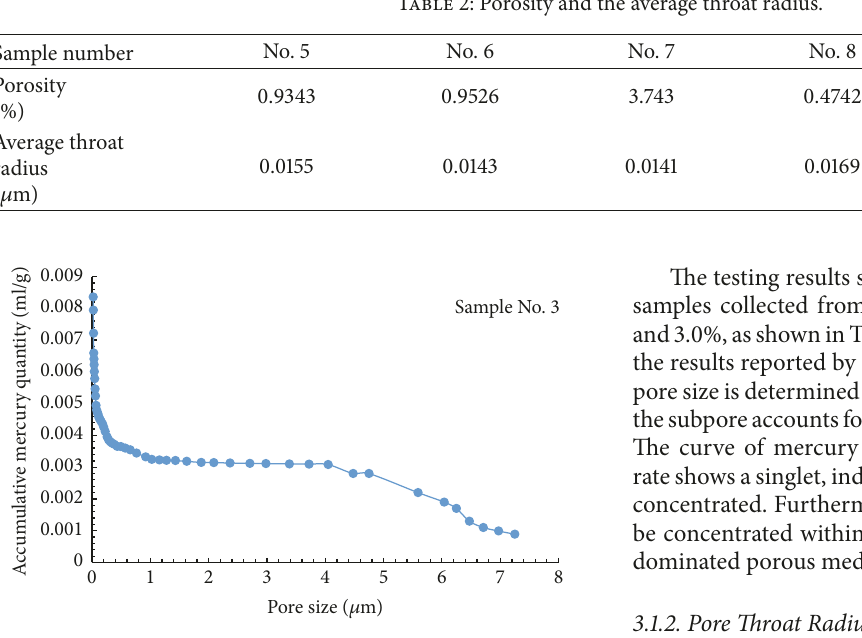
Table 2: Porosity and the average throat radius.